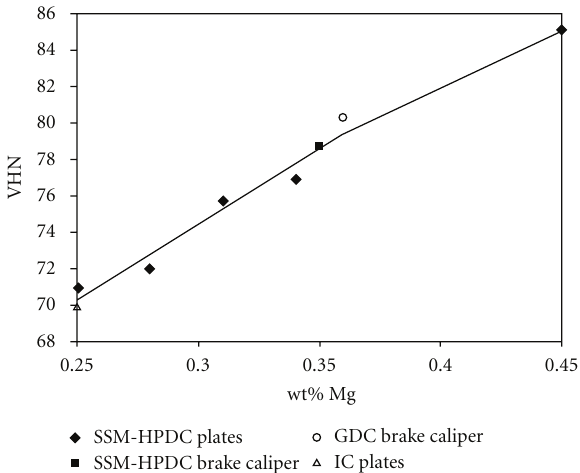
Figure 7: T4 (540 ◦ C-1 h, 120h NA) hardness values as a function of the Mg-content of A356 produced using di ff erent casting